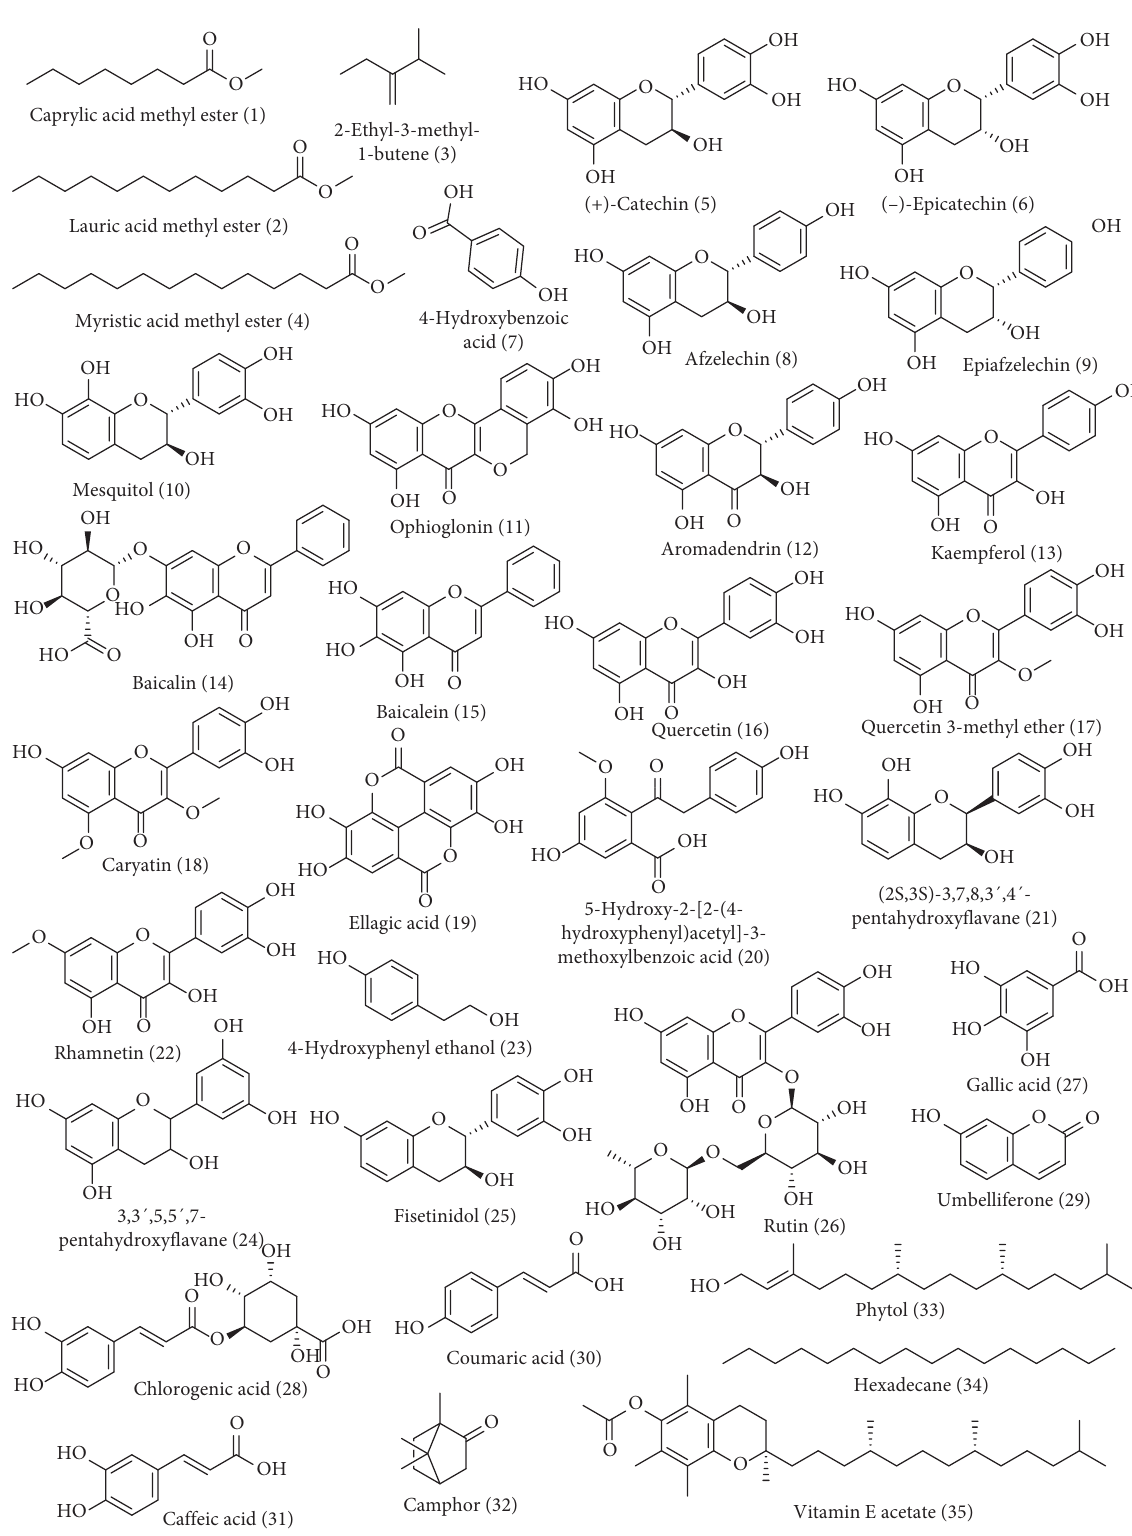
Figure 2: Phytochemicals from Acacia catechu